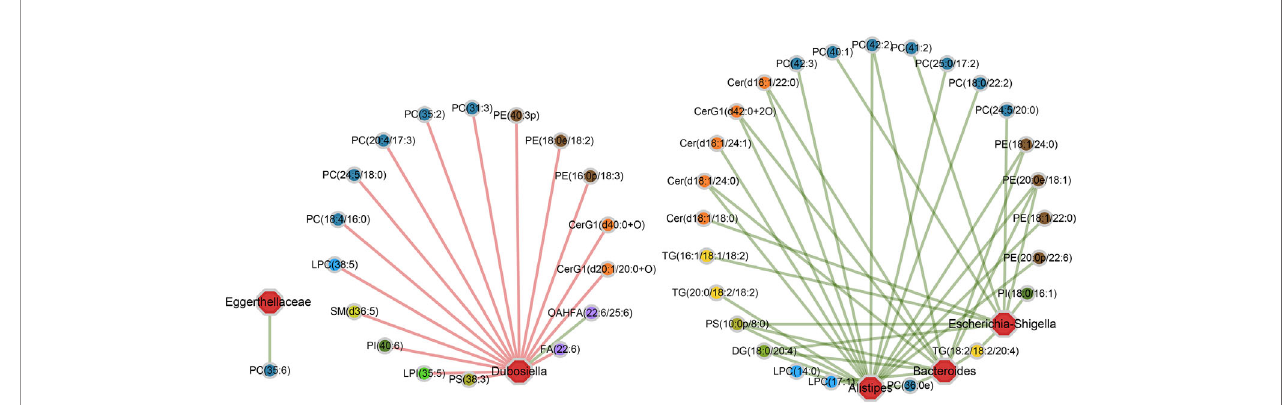
FIGURE 5 | The speci fi c “ bacterium-metabolite ” relational networks show all the signi fi cant “ bacteria genus-lipid metabolite ” pairs selected based on FDR ≤ 0.05. Lines in green and red respectively indicate positive and negative